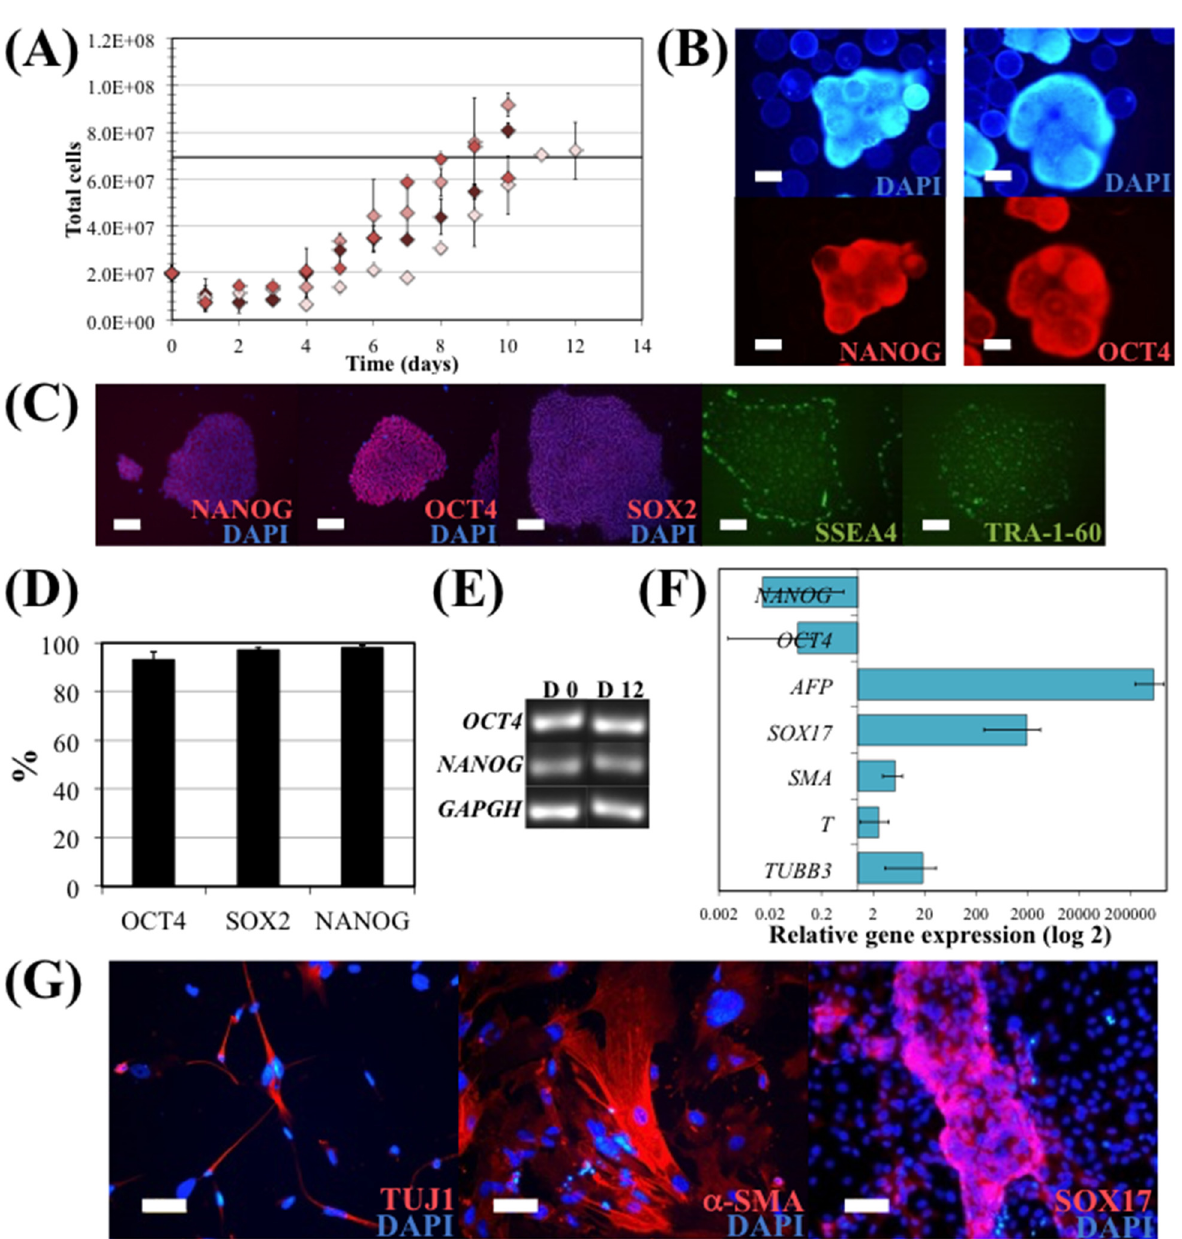
Fig 4. hiPS cell expansion in E8 medium, in a 50 mL spinner flask. EDTA clump inoculation was performed using 55,000 cells/cm 2 and a continuous agitation at 44 rpm (optimal values obtained solving the quadratic model). (A) Total cell numbers during the 10 days expansion. Maximum cell yield obtained solving the quadratic model is represented by the black line. Error bars represent SEM (standard error of the mean) of duplicate samples. (B) Immunostaining of hiPS cells cultured on microcarriers in the spinner flask with E8 medium at day 10. Cells were stained for pluripotency markers NANOG (left panel) and OCT4 (right panel), and nuclei counterstained with DAPI. Scale bars – 100 μ m. (C) Immunostaining of hiPS cells harvested from microcarriers after 10 days expansion in spinner flask and re-plated on GP. Cells were stained after 3 days for intracellular pluripotency markers NANOG, OCT4 and SOX2, and nuclei counterstained with DAPI; and for surface markers SSEA4 and TRA-1-60. Scale bars – 100 μ m. (D) Flow cytometry analysis of hiPS cells harvested from microcarriers after 10 days expansion in spinner flask. Cells were stained for OCT4 and NANOG. (E) mRNA was isolated from hiPSC at day 0 and at the end of the spinner flask culture (day 12) on microcarriers, and the undifferentiated hiPSC marker transcripts ( OCT4 and NANOG ) were analysed by RT-PCR. (F) Quantitative RT-PCR analysis of spontaneous differentiated EB of hiPSC cultured in spinner flask. The relative expression of each gene was measured against the same gene prior to differentiation. (G) Immunostaining showing the formation of cells expressing SOX17 (endoderm), TUJ1 (ectoderm) and α - SMA (mesoderm) after EB formation and spontaneous differentiation assay with hiPSC cultured in spinner flask. Nuclei were counterstained with DAPI. Scale bar: 50 μ